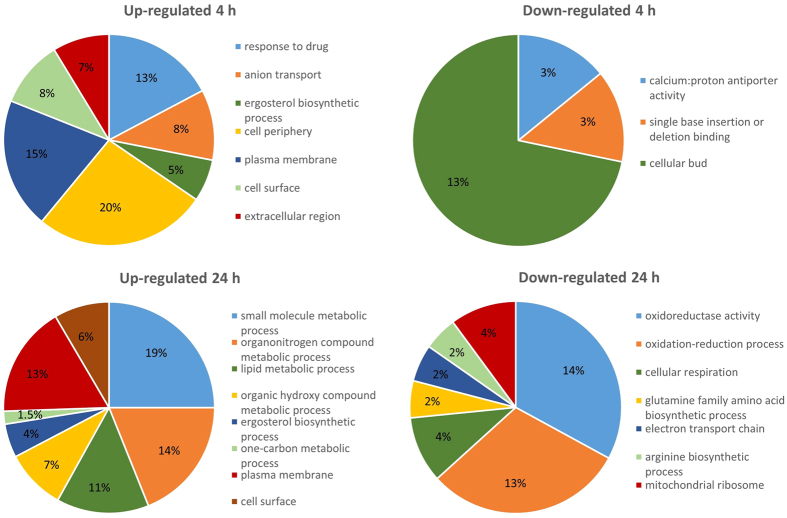
Distribution of major significantly overrepresented GO categories within the significantly up- or down-regulated gene lists at 4 h and 24 h post miconazole treatment, respectively.The percentages represent the relative amount of differentially expressed genes annotated to the respective GO category within the list of selected differentially expressed genes. Note that the sum of all represented GO categories in each pie chart is not equal to 100% since some genes belong to multiple GO categories and many of the differentially expressed genes are unannotated or annotated to GO categories that were not significantly overrepresented. Significant overrepresented GO categories were determined using the GO Term Finder at the Candida Genome Database (CGD) website (FDR adjusted p-value < 0.05).